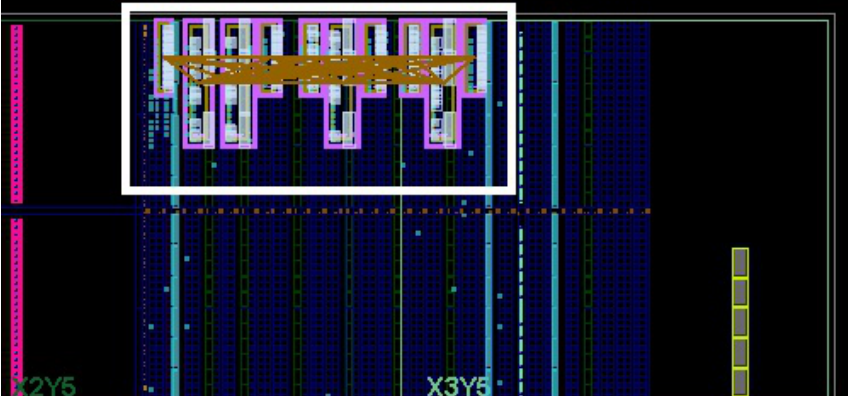
Figure 14. Floorplanning and static routing (reconfigurable area) of the physical neurons in case of the SVHN dataset